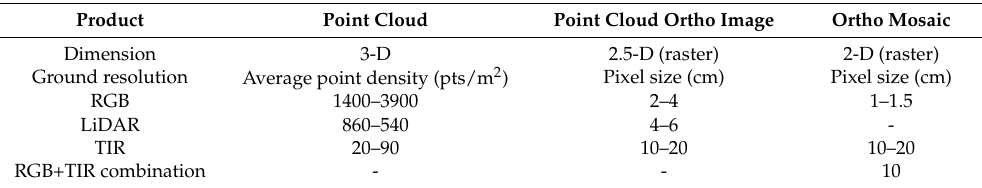
Table 3. The created geospatial